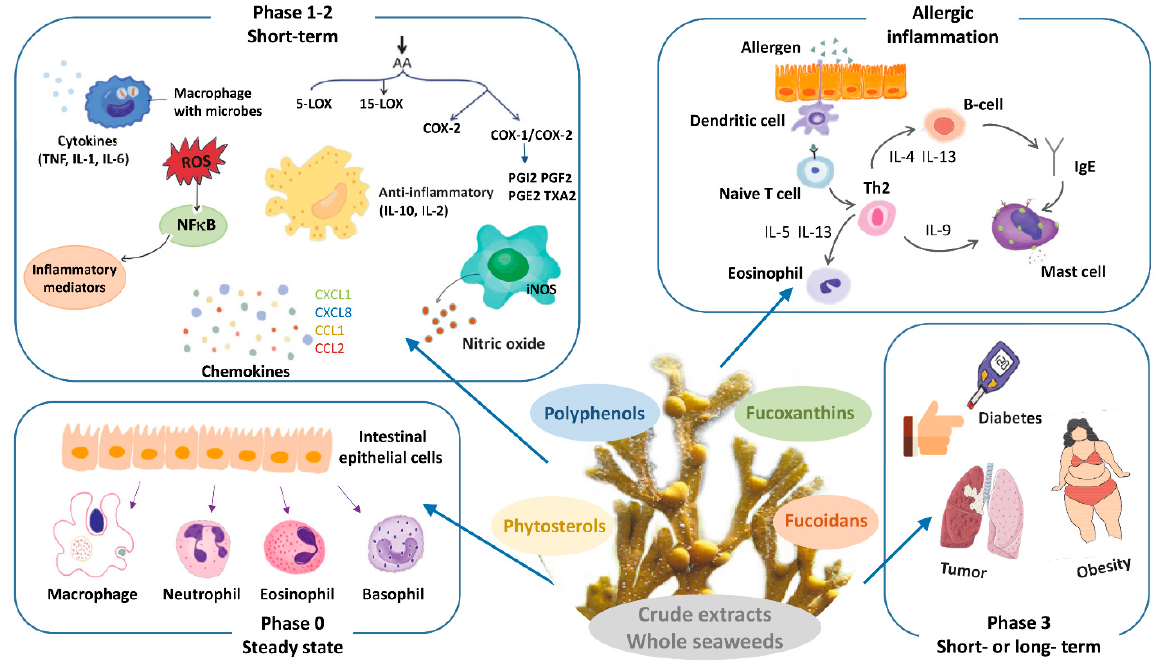
Figure 1. Schematic representation of brown seaweed and it constituents and of the phases in the immune response (Phase 0: steady state, allergy, Phase 1–2: acute inflammatory response and Phase 3: chronic inflammatory response) addressed in this review.